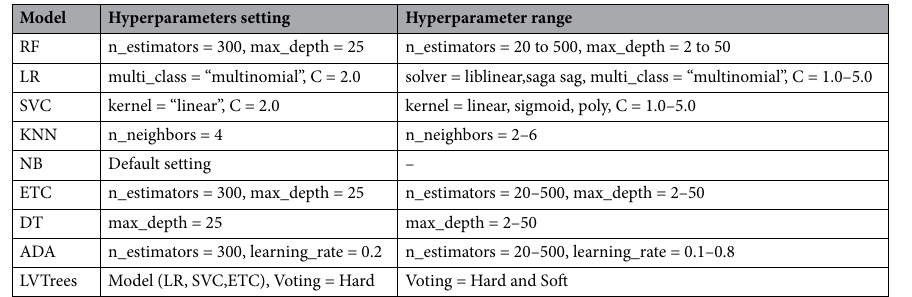
Table 9. Models hyperparameters settings and hyperparameter range used for tuning.